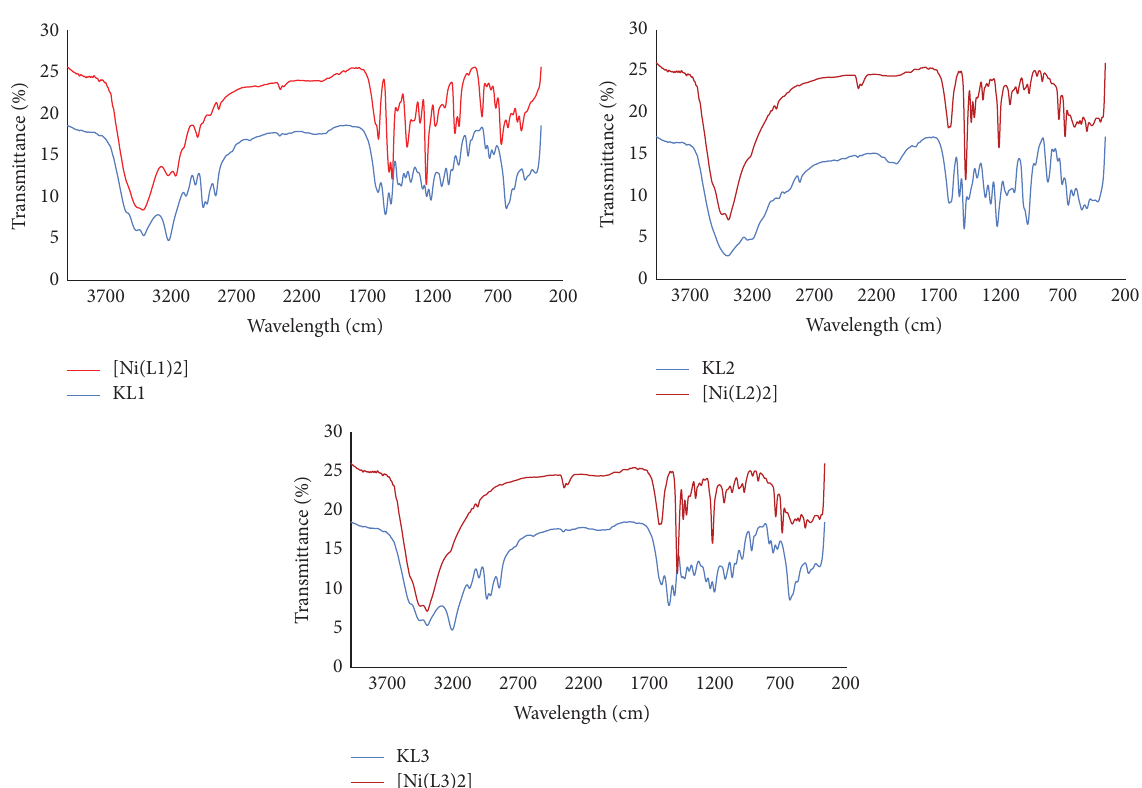
Figure 1: FTIR spectra of the dithiocarbamate ligands and corresponding Ni(II)